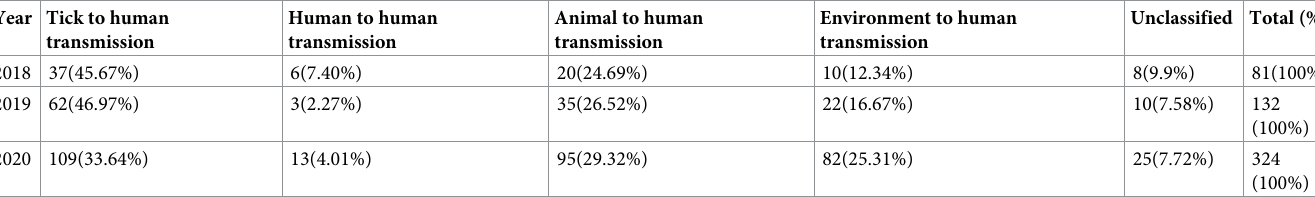
Table 1. Transmission routes of infection in 537 SFTS patients in Jiangsu Province, 2018–2020. Year Tick to human transmission